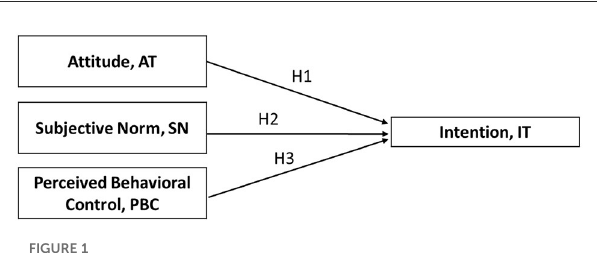
FIGURE1 Conceptual model on the correlations of attitude, subjective norms, and perceived behavioral control with intention to receive injection therapy.